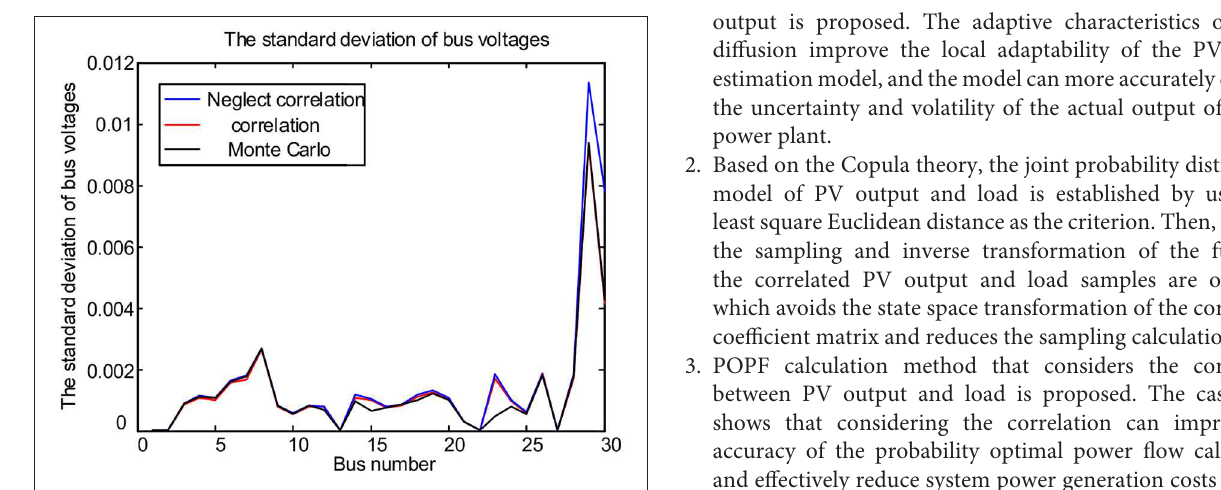
FIGURE 12 | The standard deviation of bus